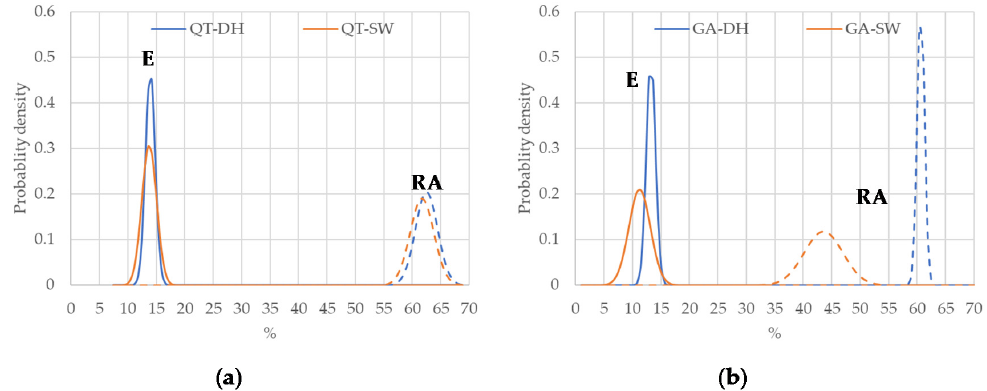
Figure 13. Probability density plot assuming a Normal distribution of average strengths and their uncertainties in Table 7 as mean and standard deviation values. ( a )Plot for the QT specimens. ( b ) Plot for GA specimens.